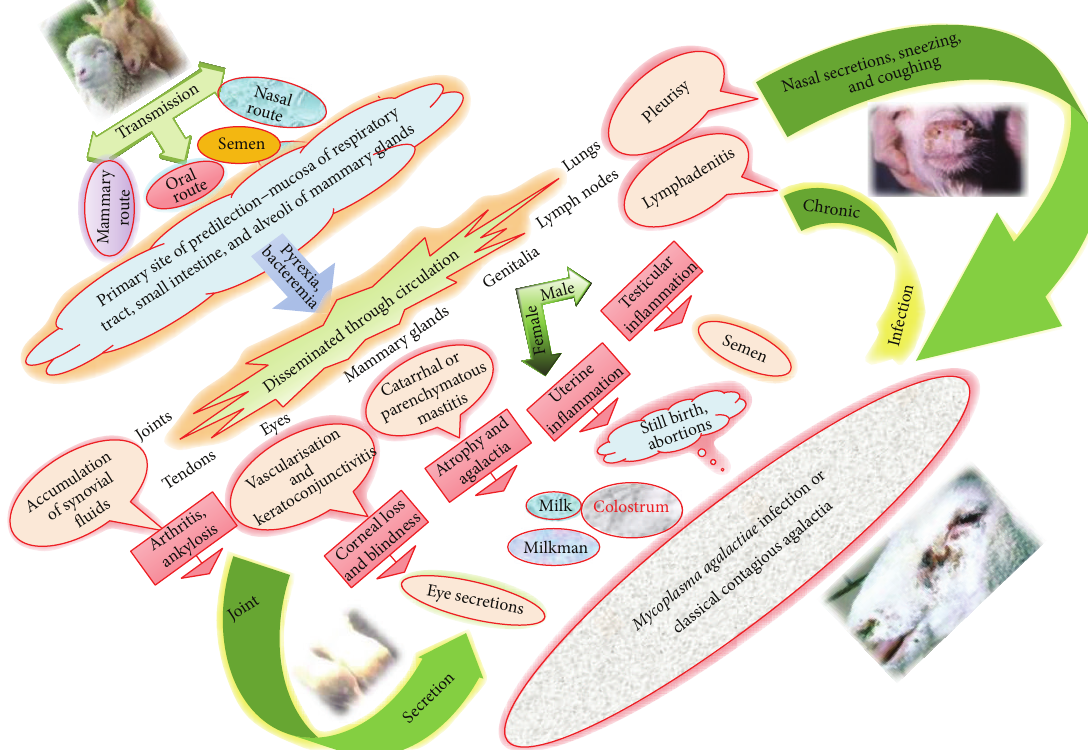
Figure 1: Transmission and pathogenesis of Mycoplasma agalactiae